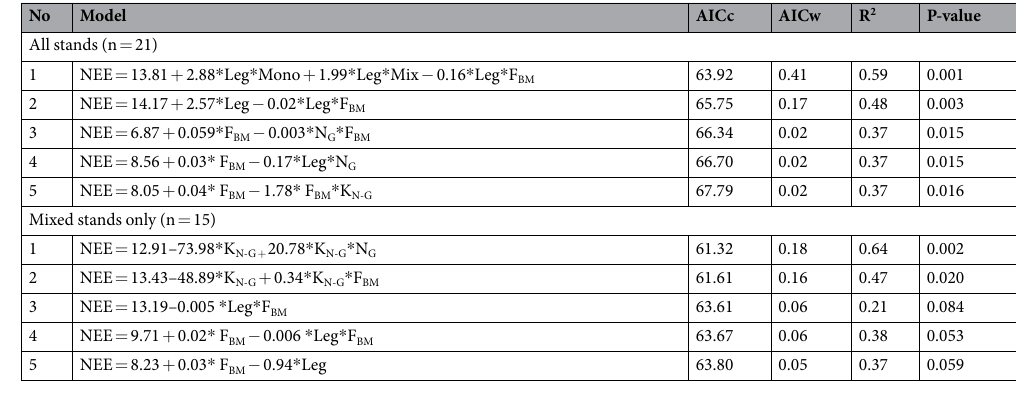
Table 3. The five best models predicting the instantaneous CO 2 net ecosystem exchange (NEE) as a function of nitrogen (N) allocation confidents (K N-F and K N-G ), foliar biomass (F BM ), percentage of legume cover (Leg) and type of stand (Mono = monospecific-dominated stands, Mix = mixed stands). AICc represents the Akaike Information Criterion adjusted for sample size whereas Akaike weights (AICw) represents the probability that a particular model is the best fit to the data. See Table 1 for a list of all